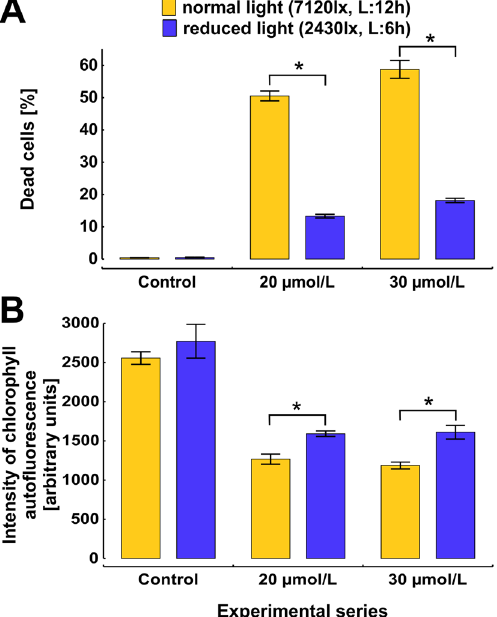
Figure 7. The effect of various light conditions on cell viability and chlorophyll a autofluorescence after 72-h exposition to different concentrations of the 12-5-12 surfactant. The percentage of dead cells ( A ) and the chlorophyll a autofluorescence in fraction of viable cells ( B ) at normal and reduced light conditions after exposure to the concentrations of 20 or 30 μmol/L of the 12-5-12 surfactant. The columns show mean values and the error bars represent standard deviation from three independent treatments. L refers to light, lx refers to lux. Statistical significance was assessed with the Student’s t test. An asterisk indicates statistically significant differences (p < 0.001 and p < 0.002 for ( A ) and ( B ) respectively).